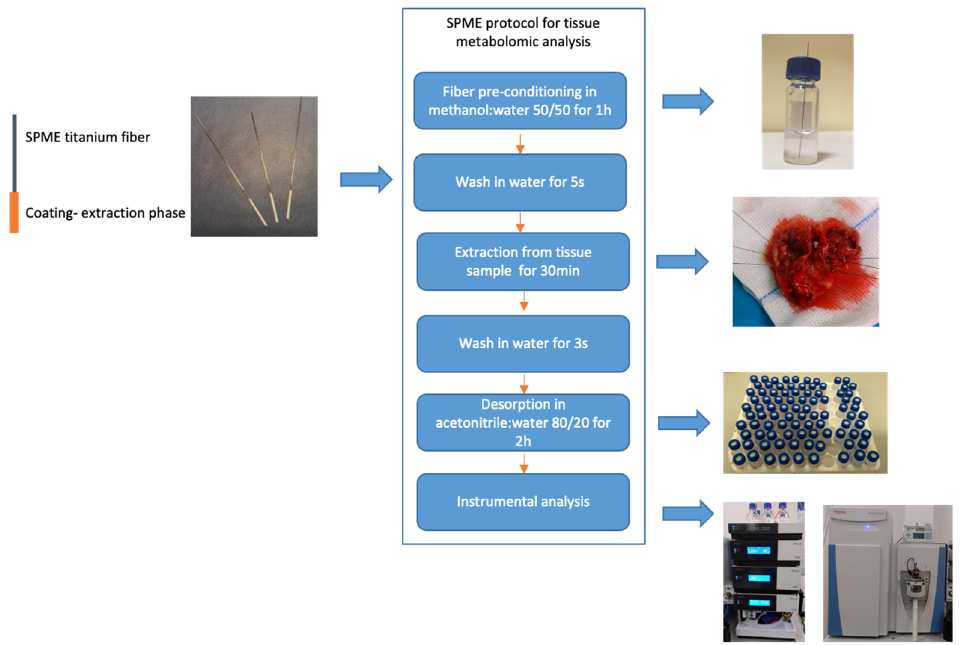
Figure 1. Sample-preparation protocol using solid-phase microextraction in brain tumors analysis.